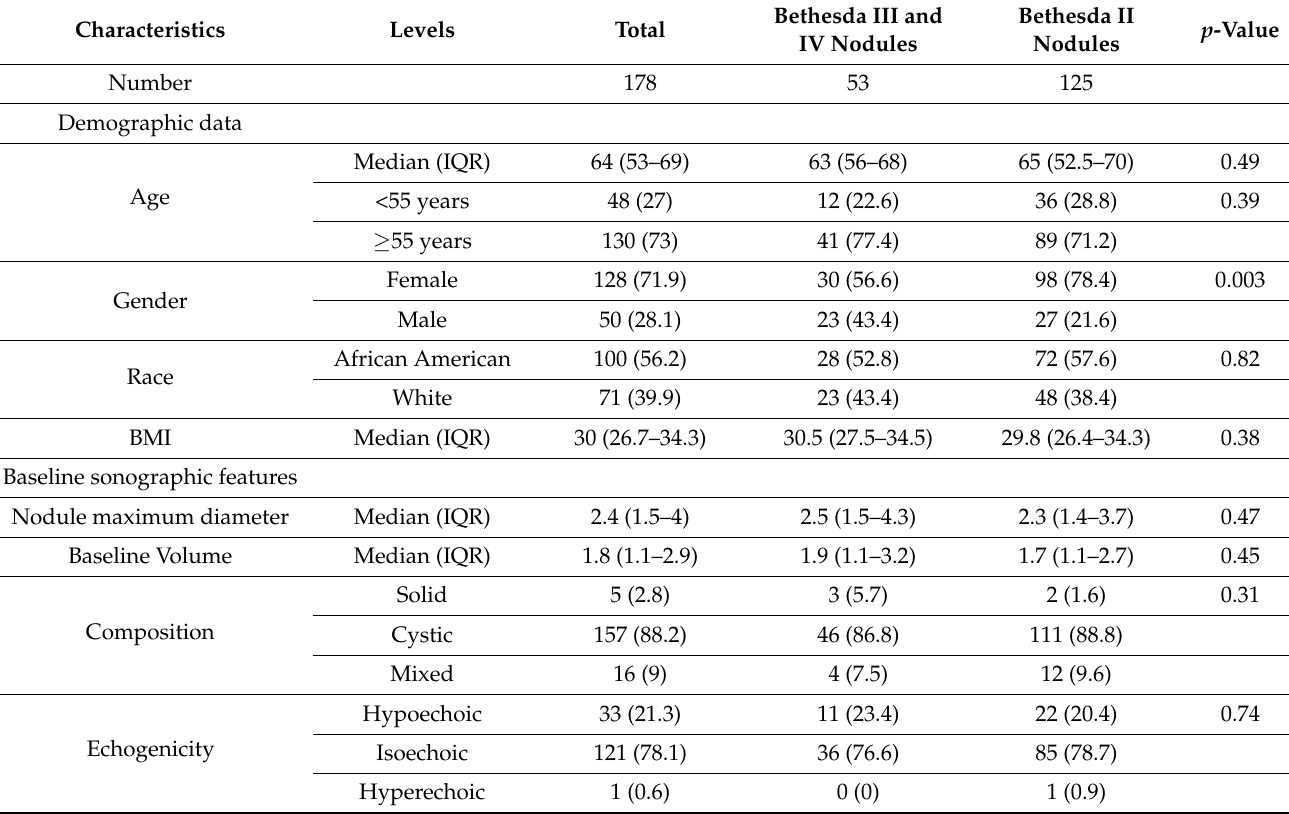
Table 1. Baseline characteristics of thyroid nodules treated with radiofrequency ablation with subgroup analysis based on preprocedural cytological